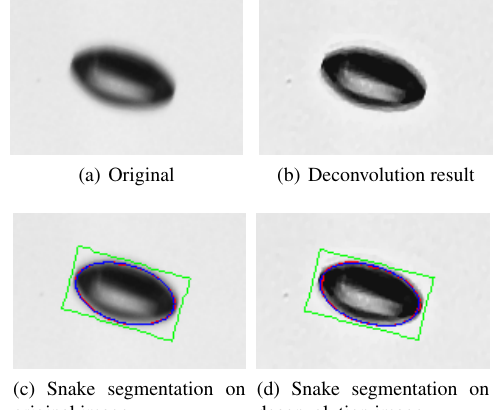
Figure 6: Measuring the bubble size with the snake algorithm. The initialization is shown in green, the snake is shown in red, while the fitted ellipse in blue.